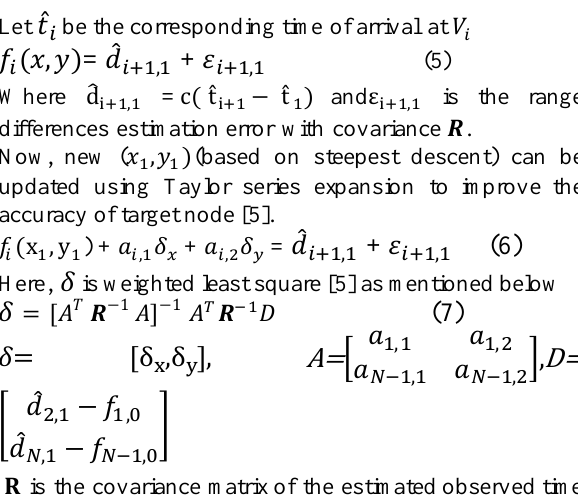
Algorithm 1: Indoor Positioning Algorithm Step 1